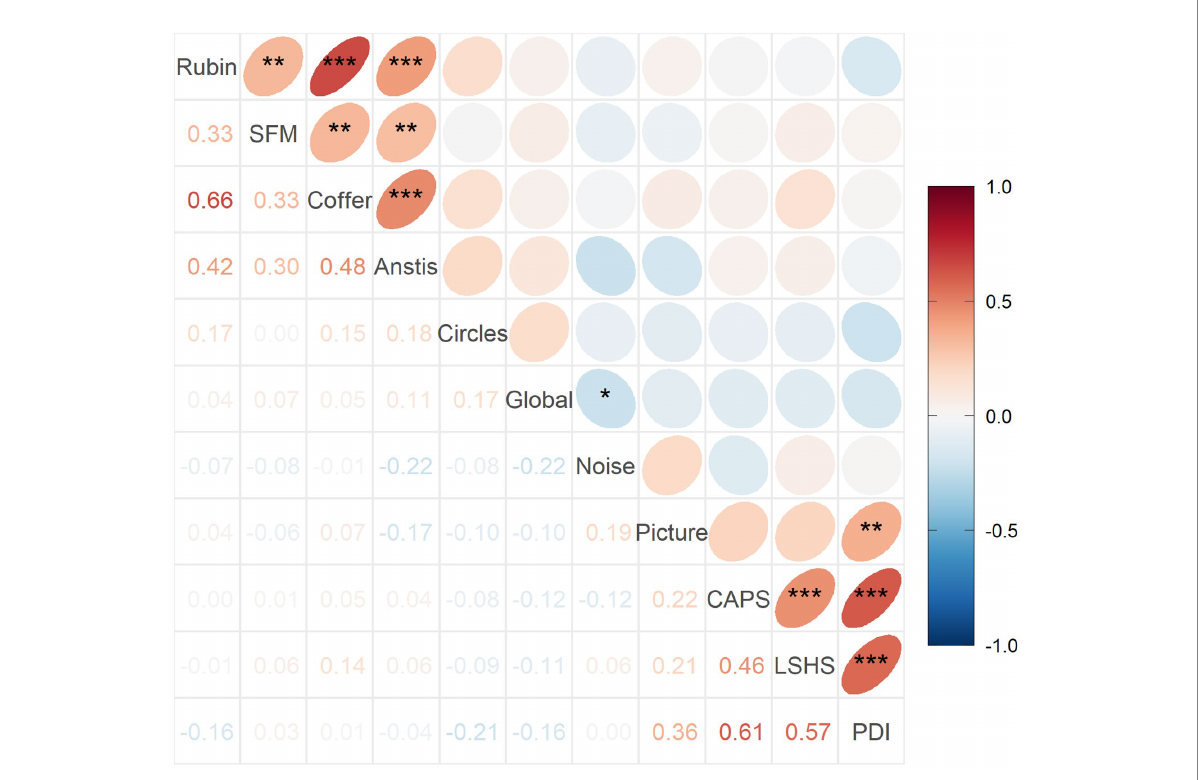
FIGURE 6 Spearman’s correlation coefficients between variable pairs and their significance. *** p < 0.001, ** p < 0.01, * p < 0.05. Corresponding Pearson’s results are shown in Supplementary Figure